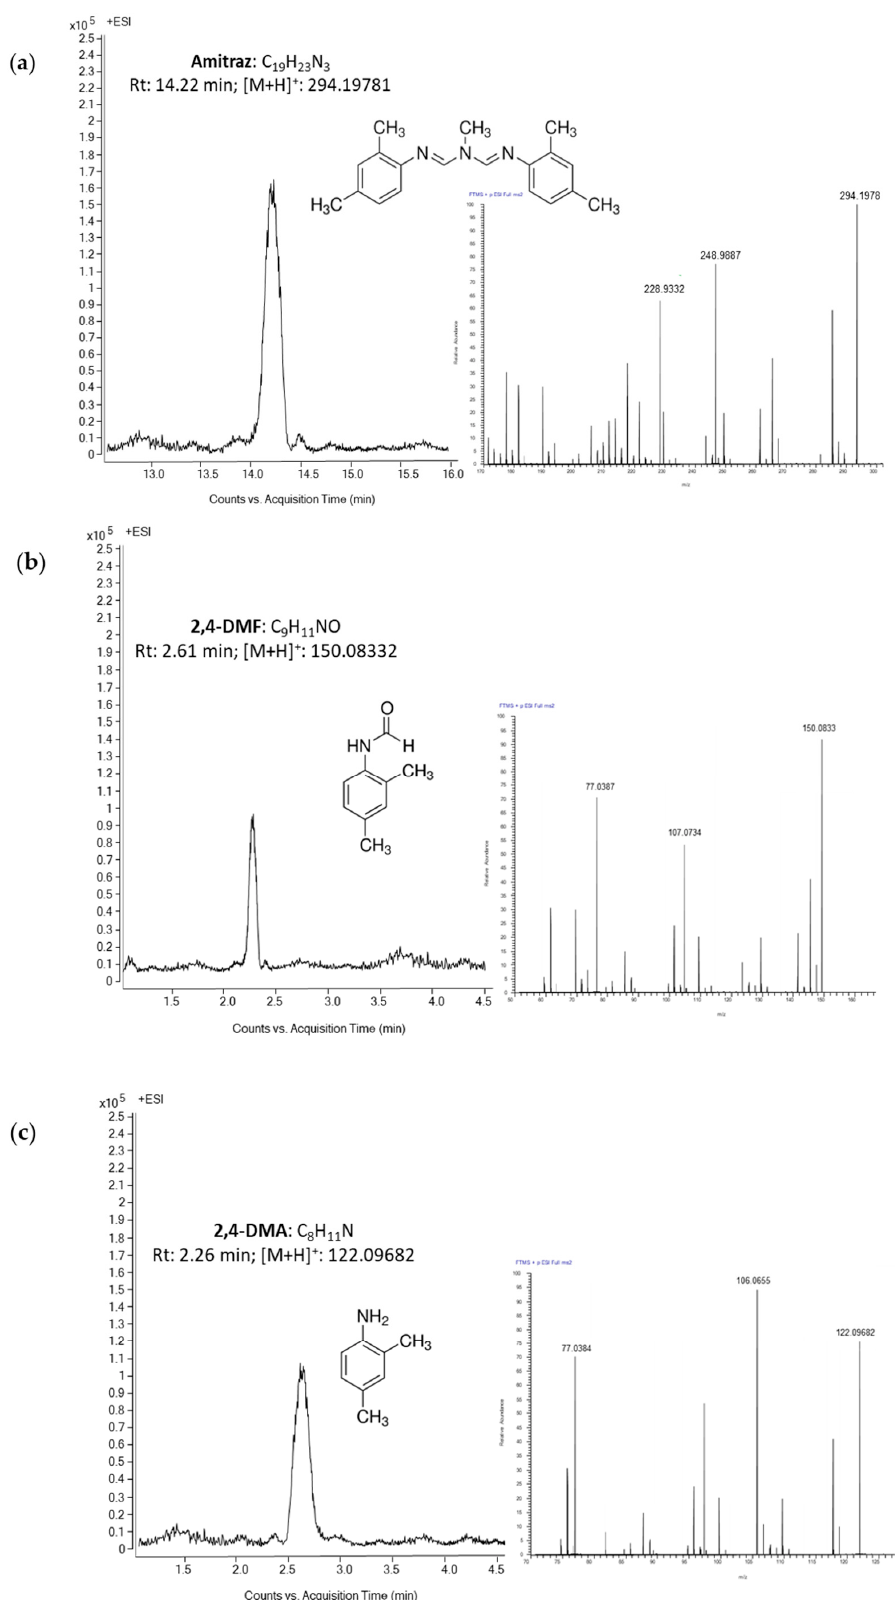
Figure 3. High-performance liquid chromatography-high resolution mass spectrometry (HPLC- HRMS) chromatograms of a honey sample spiked with ( a ) amitraz, ( b ) 2,4-DMF and ( c ) 2,4-DMA at 20 ng/g (corresponding to amitraz MRL/10).